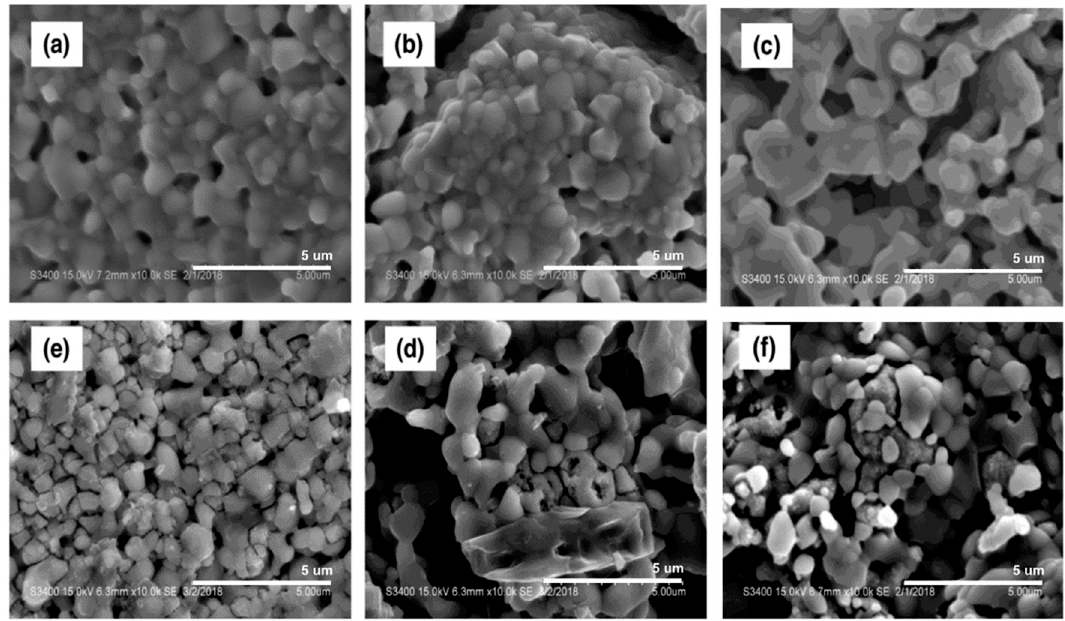
Figure 2. Scanning electron microscopy (SEM) micrographs at 10,000 × magnification for sintered NiO/ScSZ (top) and reduced Ni/ScSZ (bottom) using g/n ratios of ( a,e ) 0.27, ( b,d ) 0.54, and ( c,f ) 1.1.